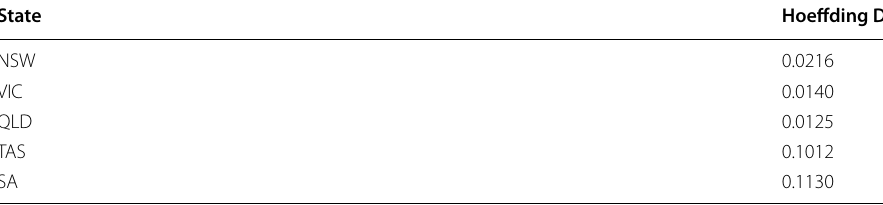
Table 1 Non-linear correlation between spot price and grid emissions intensity